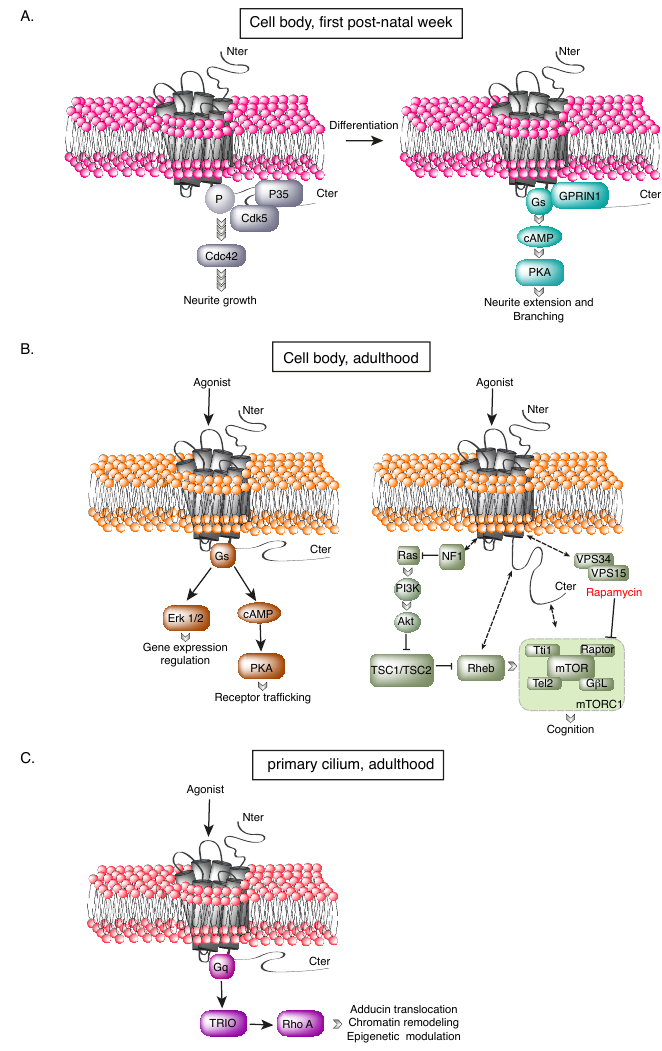
Figure 3. Spatio-temporal characteristics of the 5-HT 6 R signal transduction. Depending on its subcellular localization or developmental stage, the 5-HT 6 R can be coupled to different signaling pathways. ( A ) During the first post-natal week, the receptor is expressed at the membrane of the